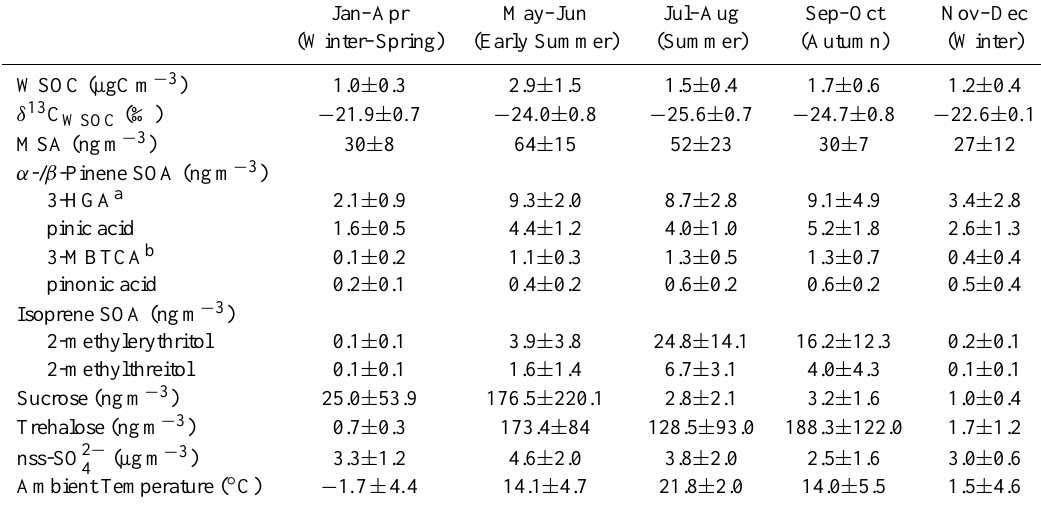
Table 1. Averages with standard deviations of each parameter near the forest floor in each season during